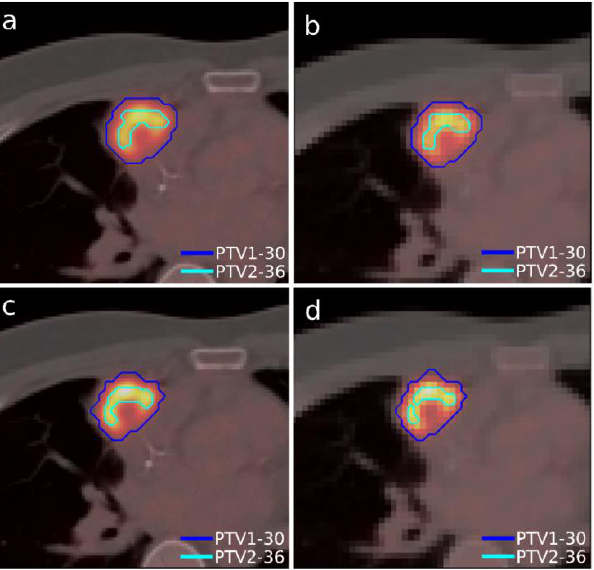
Figure 3. Segmented structures as targets in Case 2 using accreditations from EARL1 (top) and EARL2 (bottom). Contours in an isocenter axial slice of PTV1 and PTV2 on the PET/CT grid ( a , c ) and in the dose calculation grid ( b , d ). The color scale is the same for all figures.